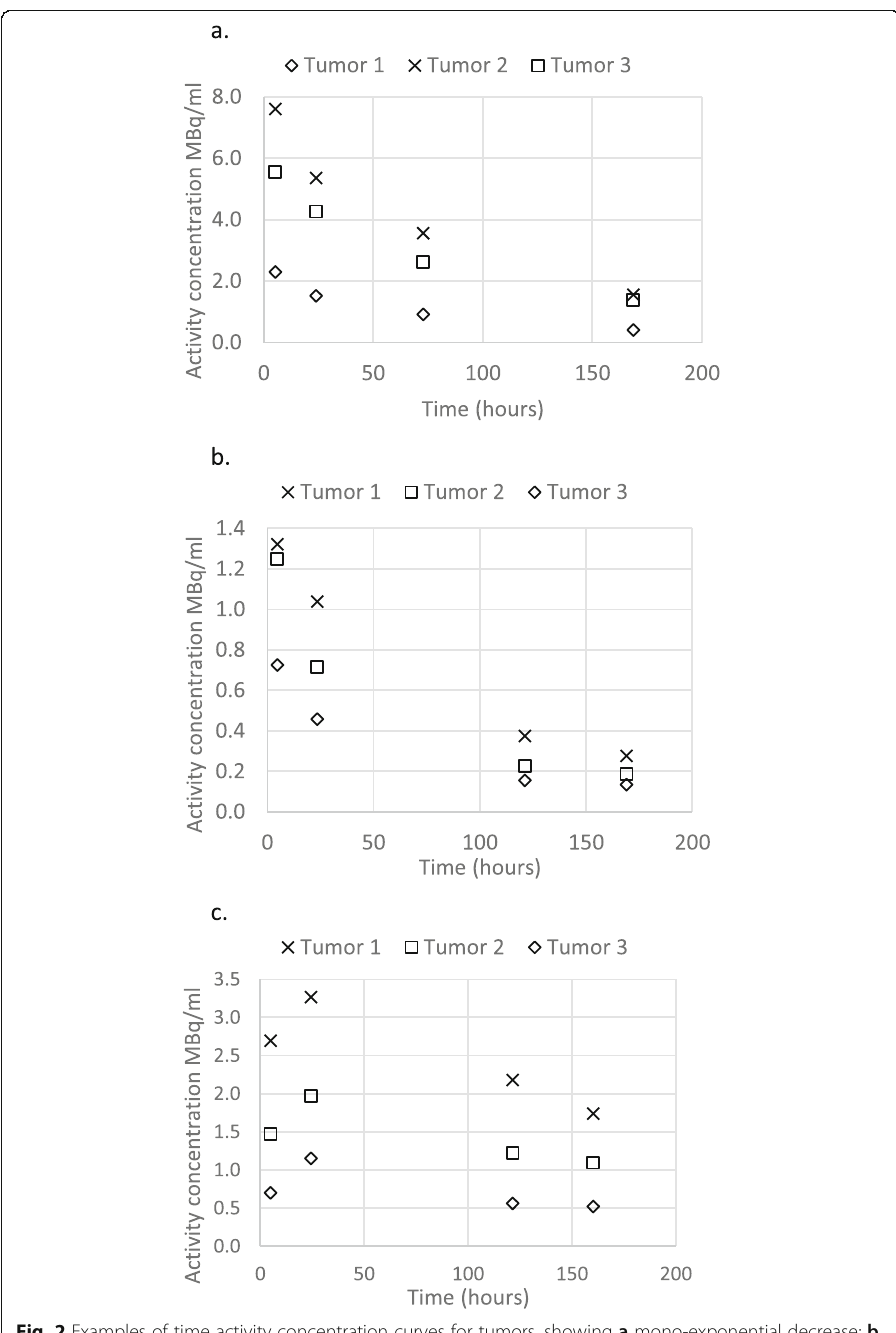
Fig. 2 Examples of time activity concentration curves for tumors, showing a mono-exponential decrease; b bi-exponential, with initial steeper decrease over first 24 h approximately, followed by mono-exponential decrease; c initial increase over first 24 h approximately, followed by mono-exponential decrease. Note that in all these graphs, tumors are labelled 1, 2, and 3 only to distinguish the curves from each other, and there is no significance to the